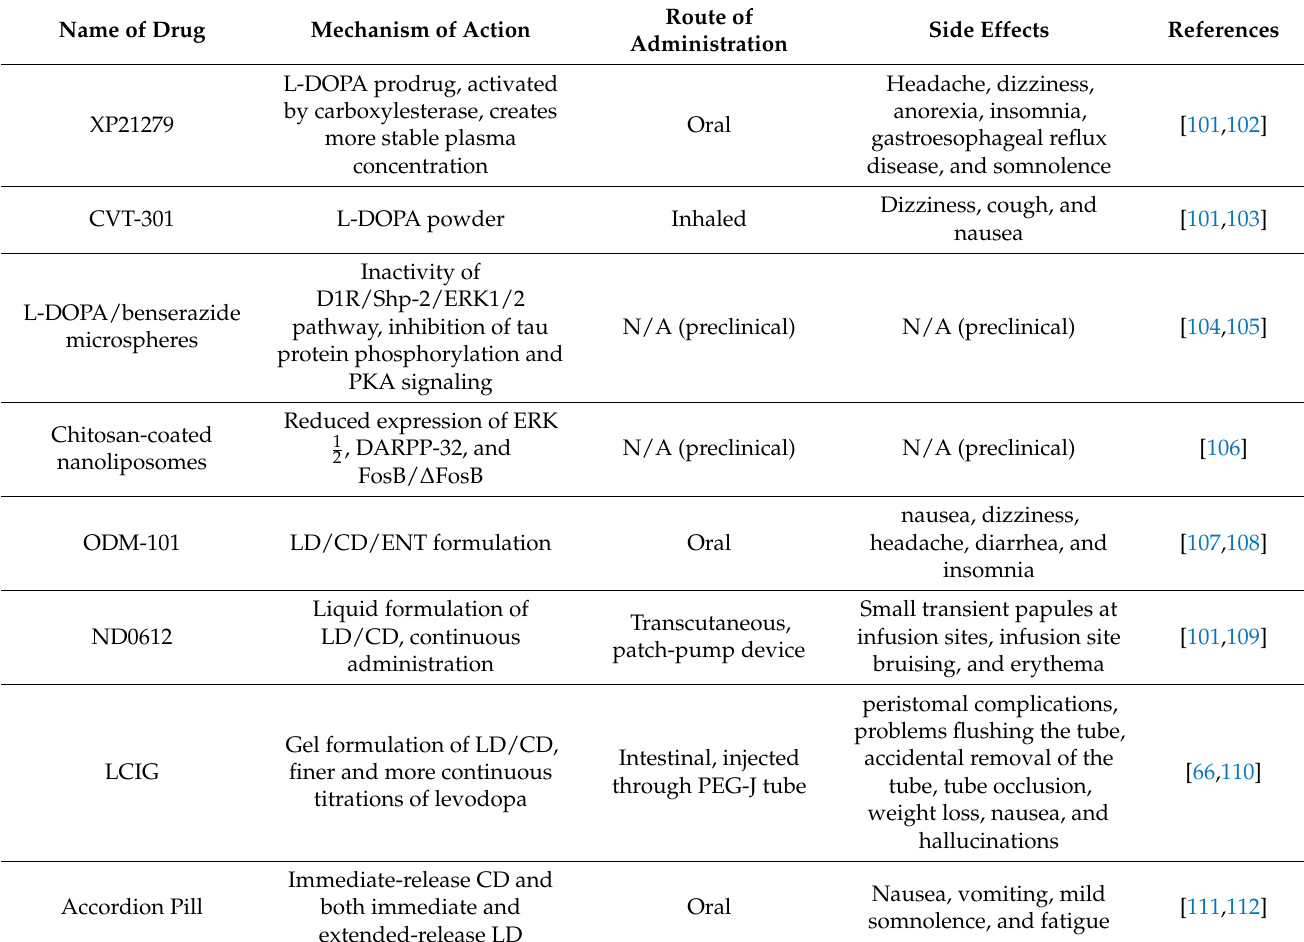
Table 3. Levodopa